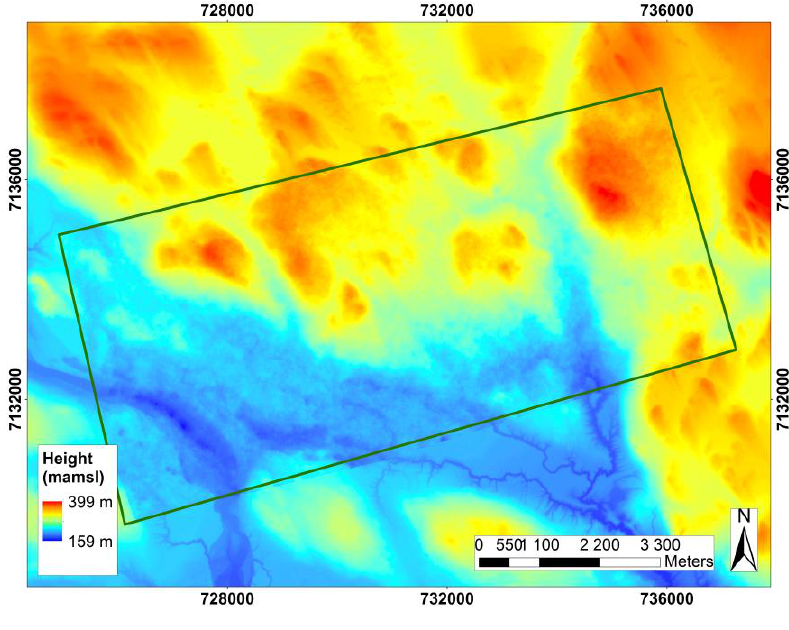
Figure 4. The Krycklan test site with an ALS DTM overlaid by a DSM (delineated in green) derived from TerraSAR-X SL